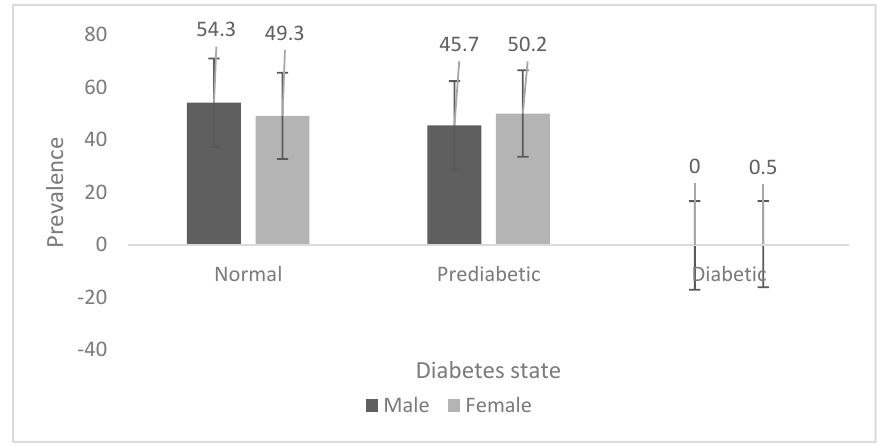
Figure 1. Prevalence of pre-diabetes and diabetes.